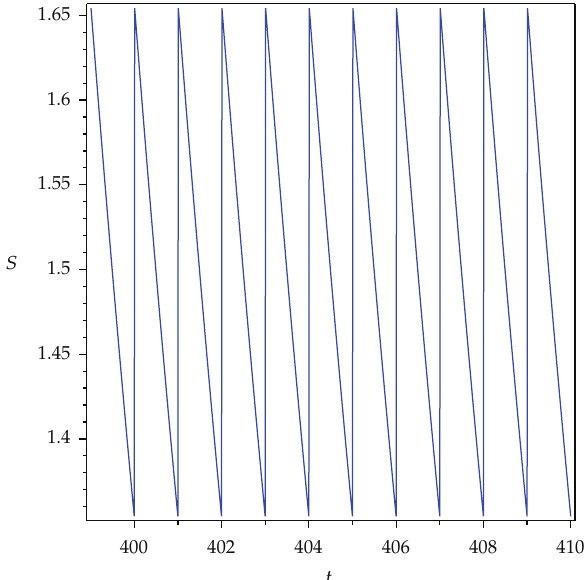
Figure 7: Time series of S (cid:3) t (cid:4) with parameters ρ (cid:7) 0 . 8 , μ (cid:7) 0 . 2 , β (cid:7) 1 . 2 , α (cid:7) 1 , r (cid:7) 0 . 6 , d (cid:7) 0 . 2 , ω (cid:7) 0 . 1 , T (cid:7) 1 , and τ (cid:7)